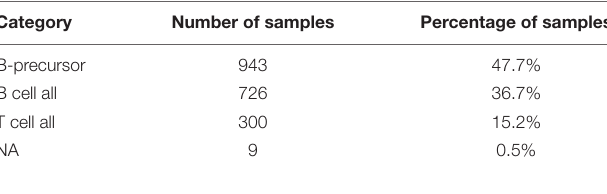
TABLE 1B | Pediatric Acute Lymphoid Leukemia - Phase II (TARGET, 2018)] used in our study classified according to their cell of origin.